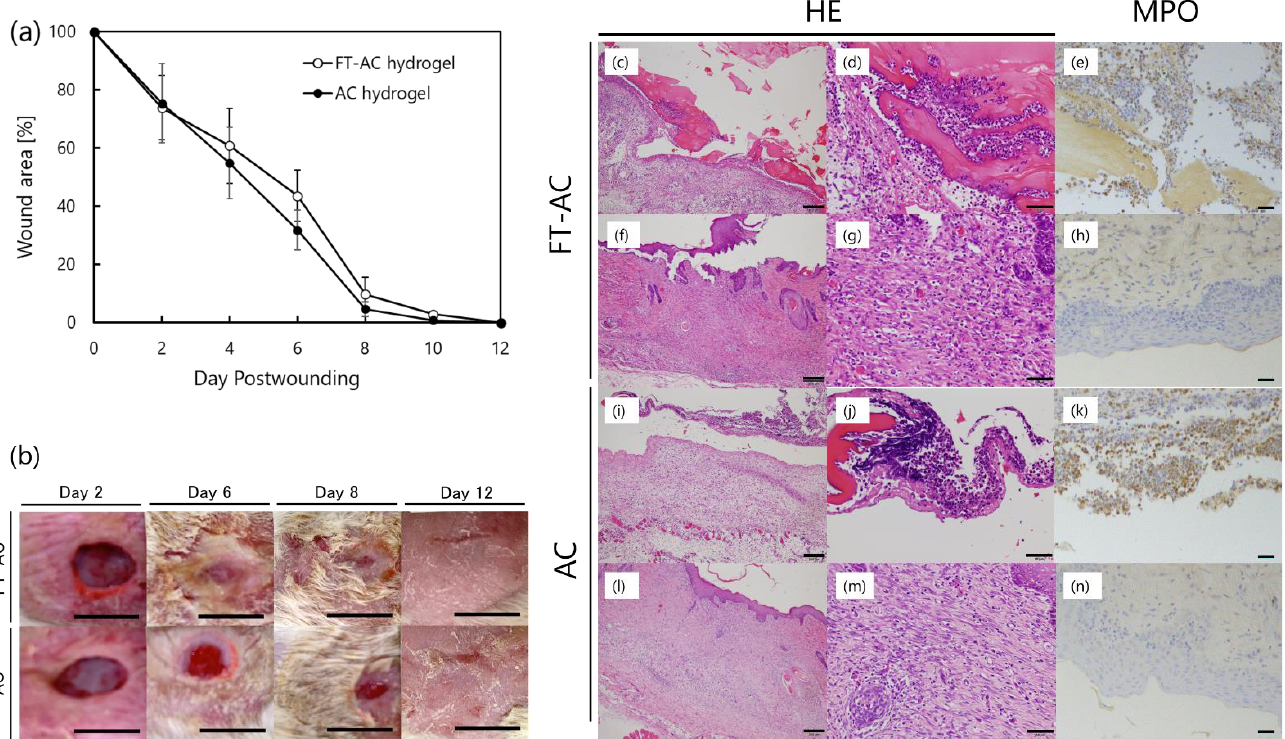
Figure 6. ( a ) Healing rate of wounds treated with CG26 AC and FT-AC hydrogels (day 0 and 2 n = 11, day 4 n = 10, day 6 n = 9, day 8 n = 8, day 10 n = 7, day 12 n = 3). ( b ) The macroscopic observation of wounds treated with FT-AC and AC hydrogel (Scale bars are 1 cm). ( c – n ) Hematoxylin- and eosin- (HE) ( c , d , f , g , i , j , l , m ) and immunohistochemically stained sections of myeloperoxidase (MPO) ( e , h , k , n ) of wound tissues treated with AC and FT-AC hydrogels of day 2 ( c , e , i , k ) and day 12 ( f , h , l , n ). ( d , g , j , m ) Magnified image of ( c , f , i , l ). Scale bars are 200 µm ( c , f , i , l ), 50 µm ( d , g , j , m ), and 100 µm ( e , h , k , n ), respectively.